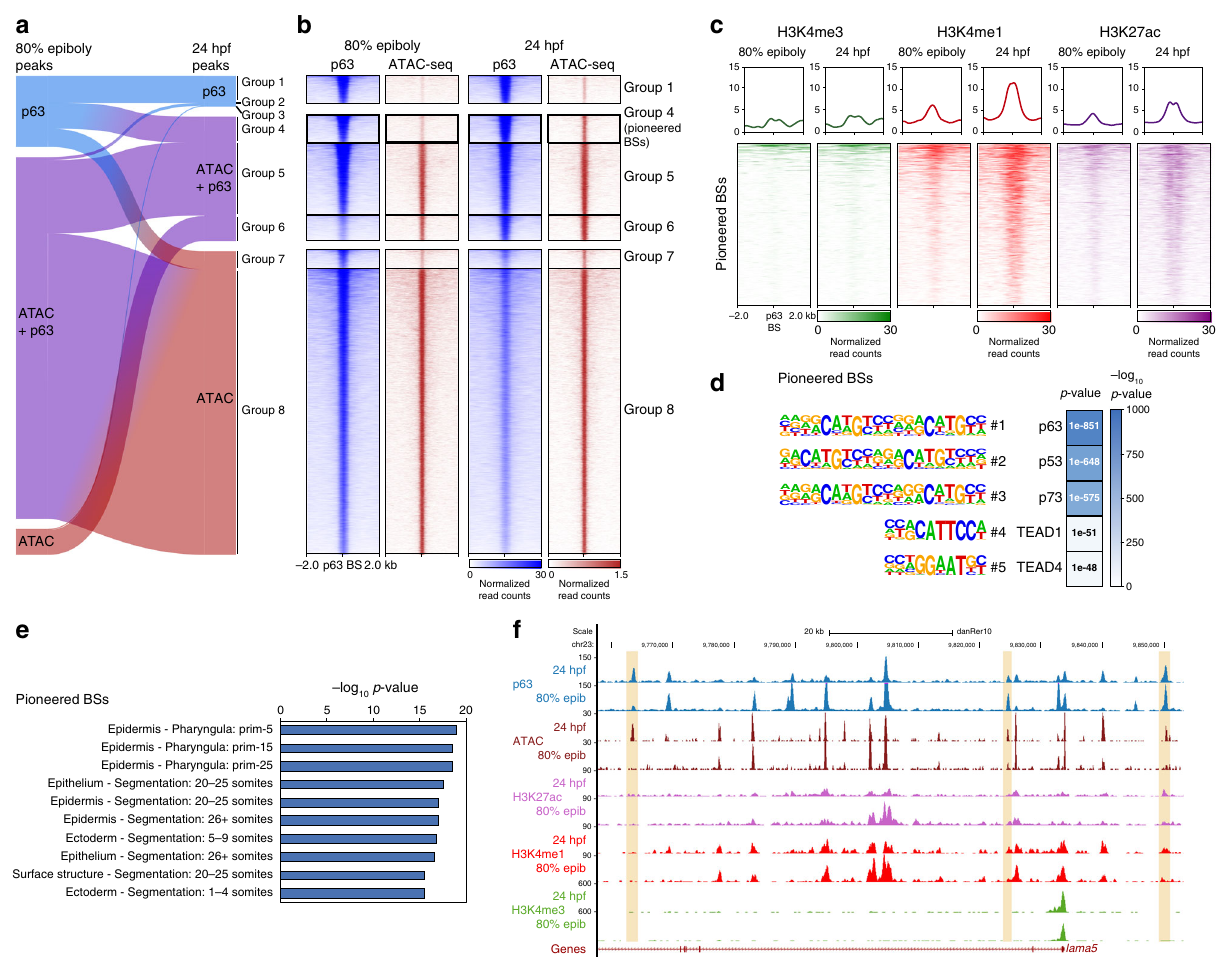
Fig. 5 p63 binding to epidermal enhancers precedes chromatin opening. a Alluvial plot showing the transition between 80% of epiboly and 24 hpf stages of the 22,583 peaks showing p63 binding (blue), chromatin accessibility (ATAC; red) or both (purple). Peaks showing no p63 binding in any of the two analyzed developmental stages were not considered. The transitions lead to eight groups of p63 BSs: group 1 ( n = 332 peaks), group 2 ( n = 145 peaks), group 3 ( n = 43 peaks), group 4 ( n = 1,284 peaks), group 5 ( n = 3,619 peaks), group 6 ( n = 1,227 peaks), group 7 ( n = 896 peaks) and group 8 ( n = 14,037). b Heatmaps of p63 and ATAC-seq signal in 80% of epiboly and 24 hpf stages for the groups resulting from the alluvial plot transitions in ( a ). Groups 2 and 3 were omitted due to their small number of peaks. c Heatmaps and average pro fi les of H3K4me3, H3K4me1 and H3K27ac in 80% of epiboly and 24 hpf for the group 4 of peaks from ( a ) (pioneered p63 BSs). d Motif enrichment analysis of the pioneered p63 BSs. The top-5 motifs are represented with their motif logos, position in the top-5, the TF name and the enrichment p -value in a color scale. e Top-10 enrichment of WT expression patterns for the genes corresponding to the pioneered p63 BSs. The -log 10 of p -value for each term is shown. f Genome tracks of p63 ChIP-seq, ATAC- seq, H3K27ac, H3K4me1, and H3K4me3 in the indicated developmental stages showing signal intensities in a region of chromosome 23. Pioneered p63 BSs associated to the epidermis-expressed gene lama5 are highlighted in light orange. The Genes track represents ENSEMBL annotated genes. See also Supplementary Fig.